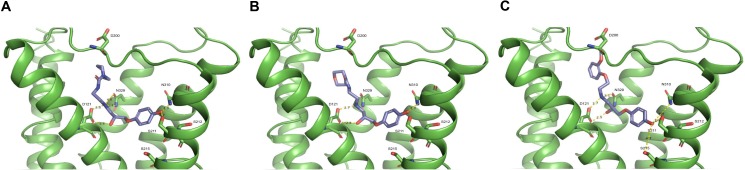
Crystal structure of ADRB1 with xamoterol (S) (cyan, panel A), xamoterol (R) (blue, panel B), and STD-101-D1 (salmon, panel C) docked into the ligand-binding site. The transmembrane regions are shown as green ribbons, and. Putative interactions are displayed as yellow dashed lines with estimated distance in angstroms (Å). The carbon-nitrogen chain of xamoterol (S) is predicted to pack approximately 1.0 Angstroms closer to D121 and Transmembrane Helix 3 compared to xamoterol (R), and its morpholino ring rests in a rotated pose as well.